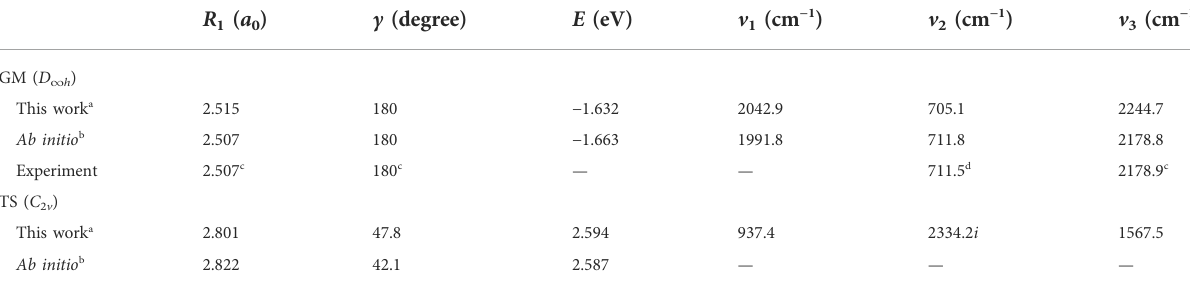
TABLE 2 Structures, energies and vibrational frequencies of the GM and TS for the ground-state BeH 2 .